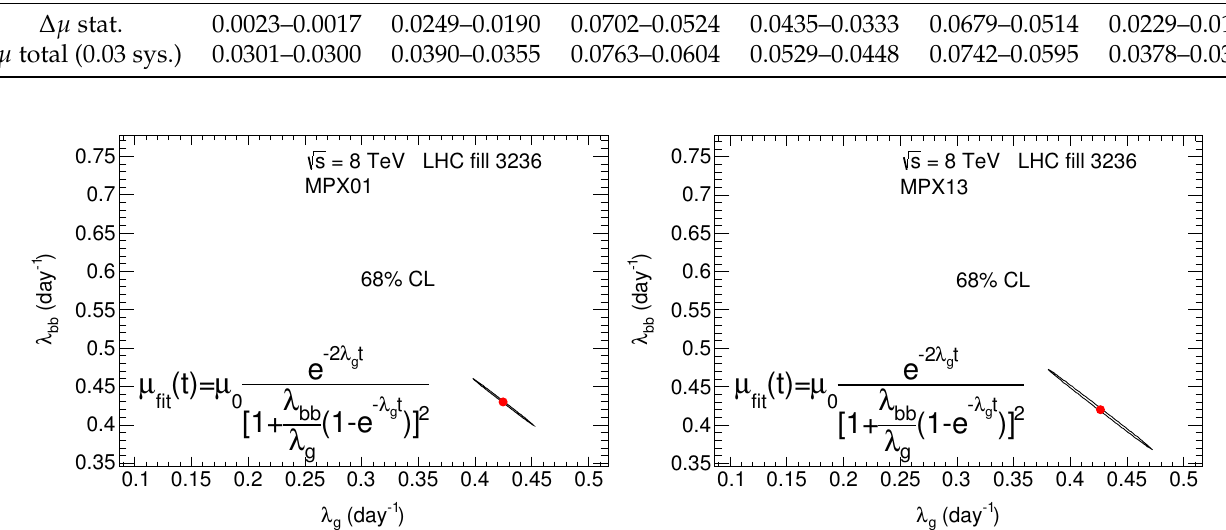
Figure 18. Contour curves of λ g and λ bb , given at 68% CL, for the fit results of the average number of interactions per bunch crossing as a function of time seen by MPX01 and MPX13. The dot in the center of the contour indicates the fit values. The hit statistical uncertainties and systematic uncertainties from luminosity fluctuations not described by the fit function are added in quadrature, given in Table 9, and then scaled to yield χ 2 /ndf = 1. LHC fill 3236. Taken from Ref.